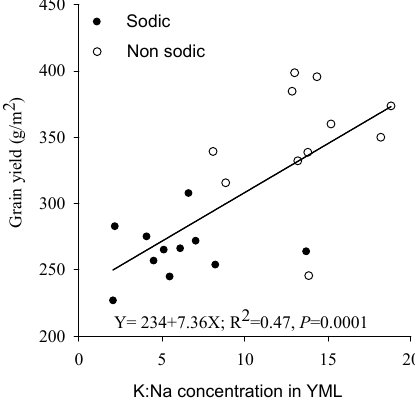
Figure 8. Relationships between grain yield of barley genotypes with potassium:sodium concentration ratios in young mature leaves of barley genotypes grown on a sodic site and a non ‐ sodic site at Goondiwindi in southern Queensland in 2008.